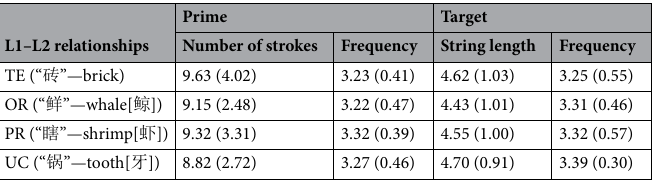
Table 2. The descriptive statistics (mean and SD ) of the number of strokes, string lengths, and frequency (log10W) across the Prime-Target conditions.